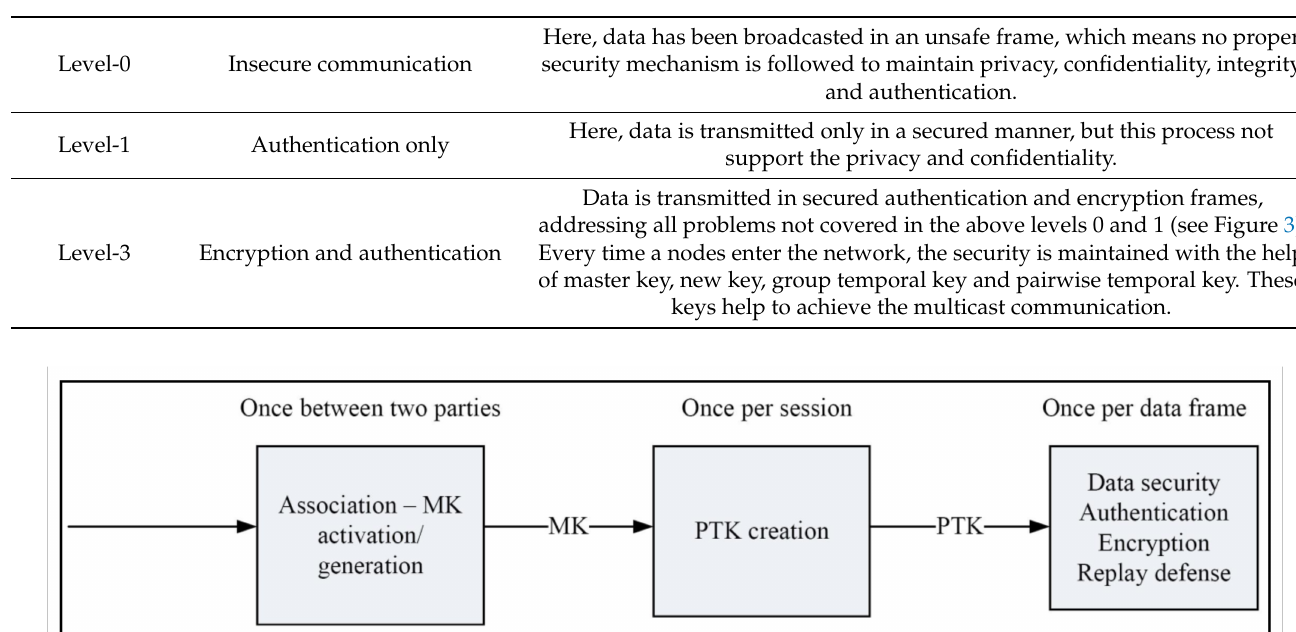
Table 3. Security in IEEE 802.15.6 standard.